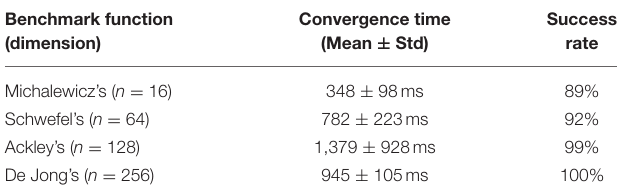
TABLE 1 | Parameter optimization of benchmark objective functions.